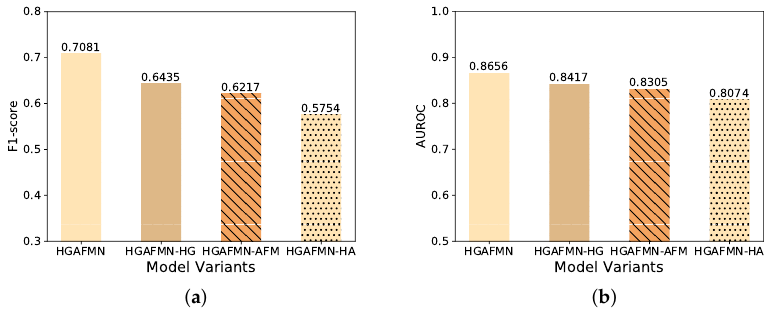
Figure 9. ( a ) Experimental results of model variants on F1-score; ( b ) experimental results of model variants on